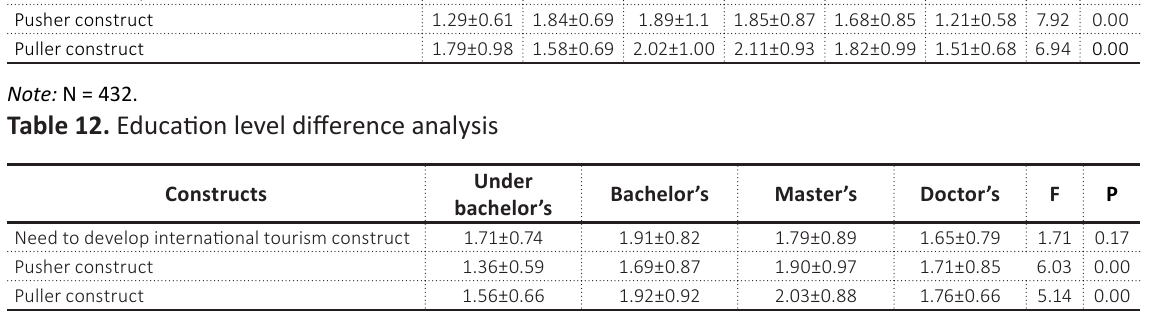
Table 11. Income difference analysis Constructs